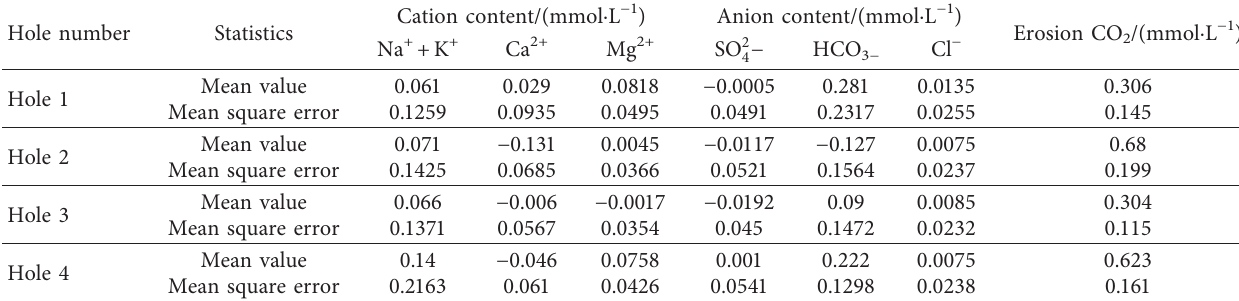
Table 2: Differences in the ion contents between the initial solution and dissolution